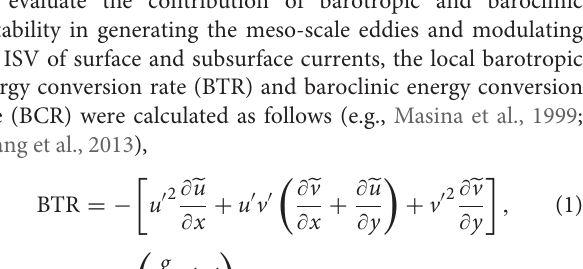
FIGURE 1 | Locations of ADCP moorings deployed by Institute of Oceanology, Chinese Academy of Sciences at 130 ◦ E (the mooring used in this study is marked by red pentagram). The color map shows the topography of the WTP derived from the etopo2v2 dataset. Contours show the mean sea surface height from satellite altimetry